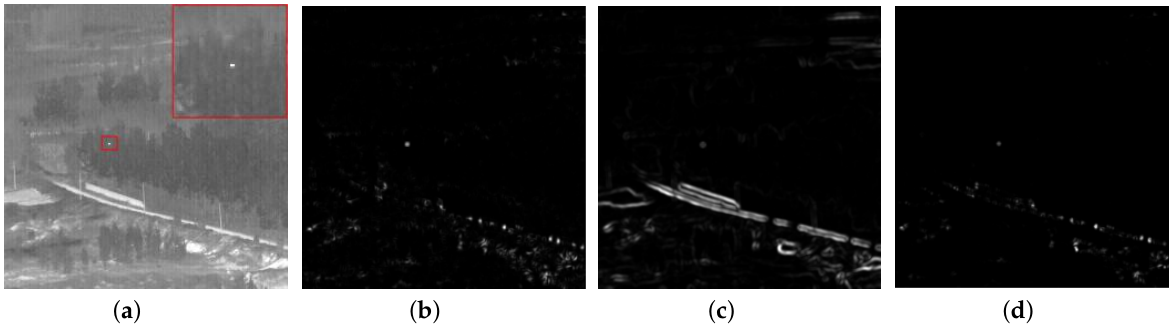
Figure 3. Local a priori extraction method proposed by the PSTNN algorithm. ( a ) Infrared image con- taining dim and small targets; ( b ) weighted image describing corner point information; ( c ) weighted image describing background information; ( d ) final obtained weighted